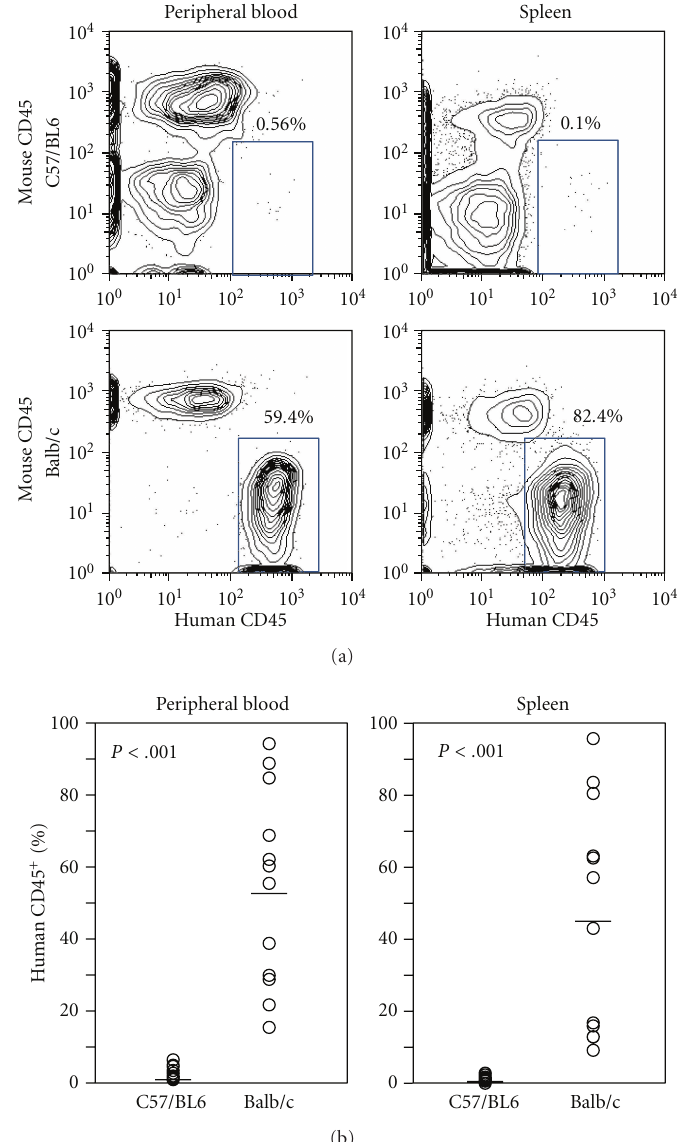
Figure 2: Balb/c Rag-2 − / − Jak3 − / − mice support human hematopoietic stem cell engraftment more e ffi ciently than C57/BL6 Rag-2 − / − Jak3 − / − mice. Cord blood-derived CD34 + cells (2 × 10 5 cells/ mouse) were transplanted into irradiated newborn mice intrahepatically. Peripheral blood of CD34-transplanted recipients was obtained 12 weeks after transplantation, and human and murine chimerism was assessed by flow